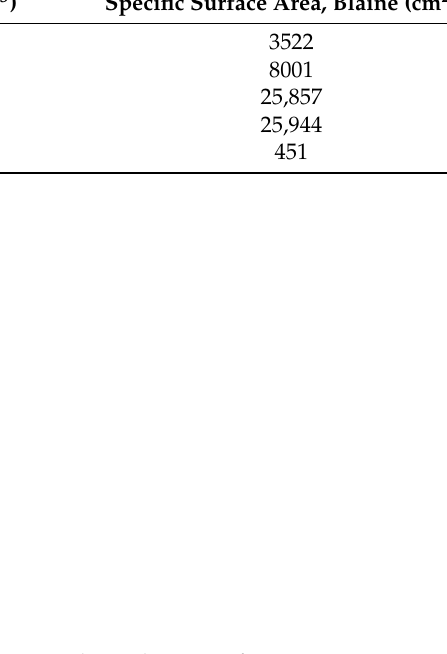
Figure 1. Particle size distribution (PSD) of the materials used to manufacture ternary cements.